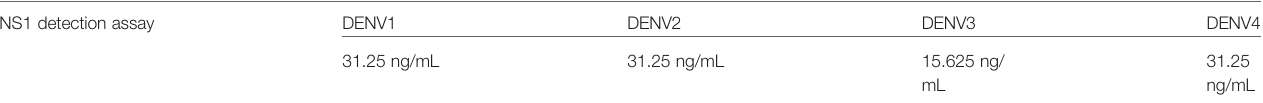
TABLE 2 | Detection limits of DENV serotype NS1 multiplex